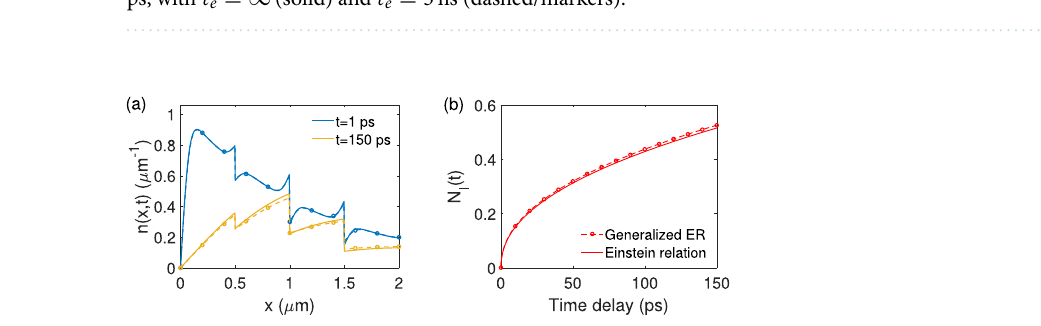
Figure 7. Impact of photoelectron decay in the AL on the distribution of n ( x , t ) at ( a ) t = 10 ps and ( b ) t = 150 ps, with τ e = ∞ (solid) and τ e = 3 ns (dashed/markers).